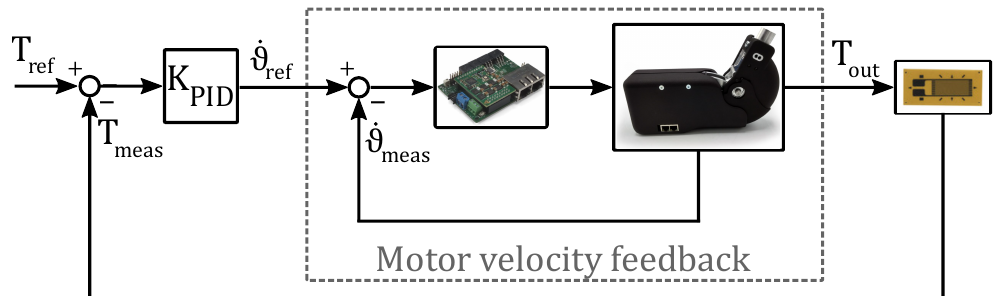
Figure 16. Block-diagram of the cascade controller used for the SMARCOS prototypes. The output torque is measured by the strain gauges and the torque error is fed into a PID controller, which converts it into a motor velocity reference for the inner loop. The latter is a low-level velocity control available within the Maxon ESCON module plug in the SMARCOS